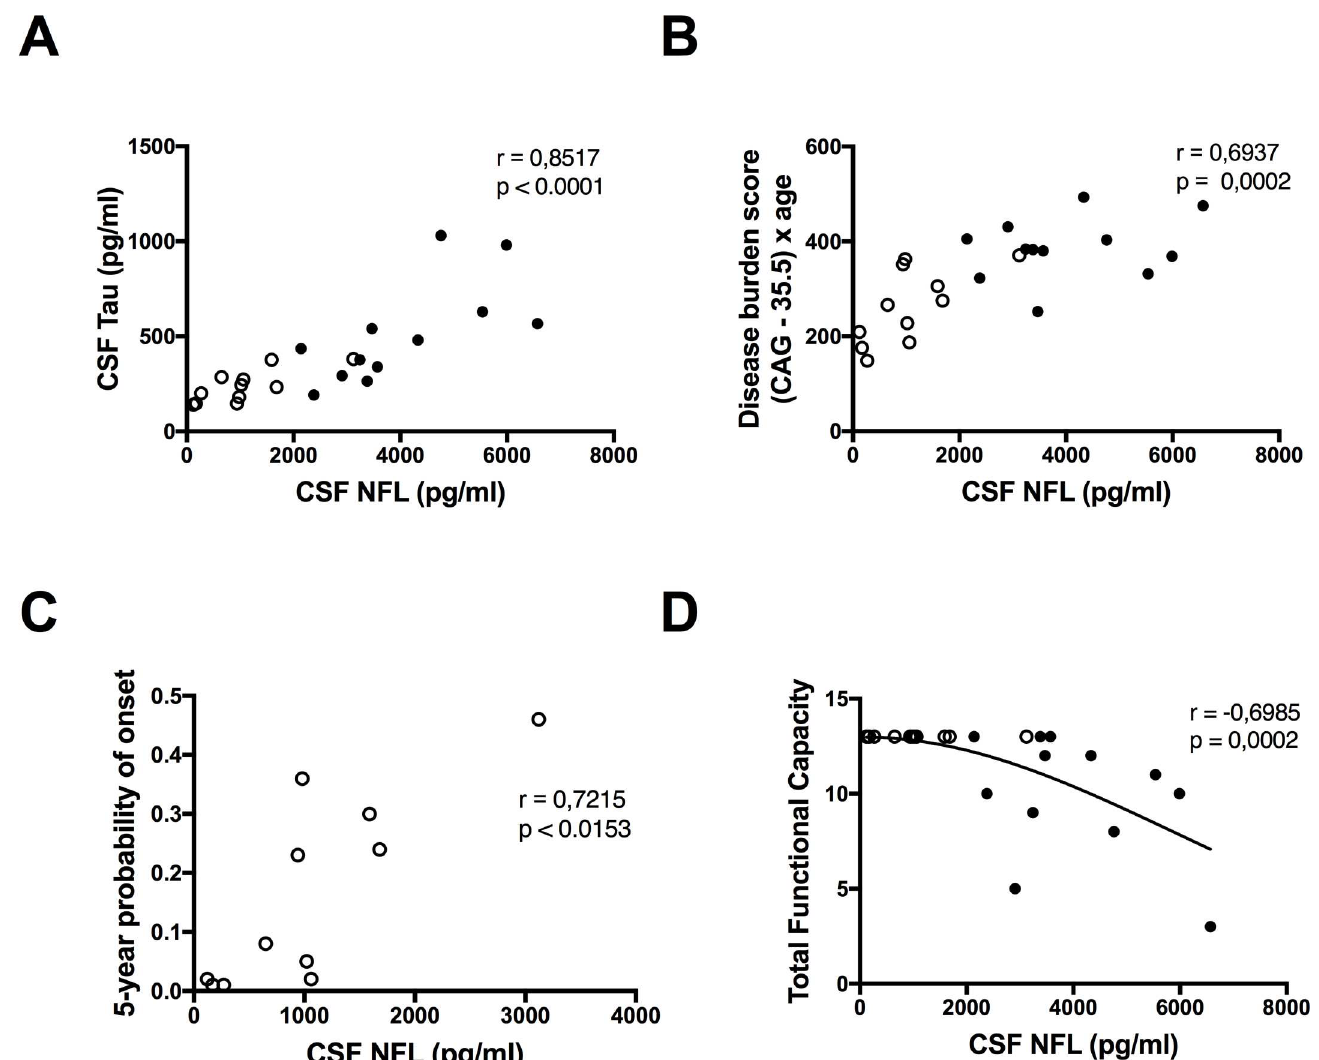
Fig 1. Correlations between NFL and disease progression in Huntington’s disease. ( A ) Neurofilament light (NFL) and tau levels are significantly correlated. NFL correlates positivelywith ( B ) diseaseburdenand ( C ) 5-year probabilityof diseaseonset but negativelywith ( D ) total functional capacity. ○ Premanifest gene expansioncarrier • Manifest Huntington ’ s